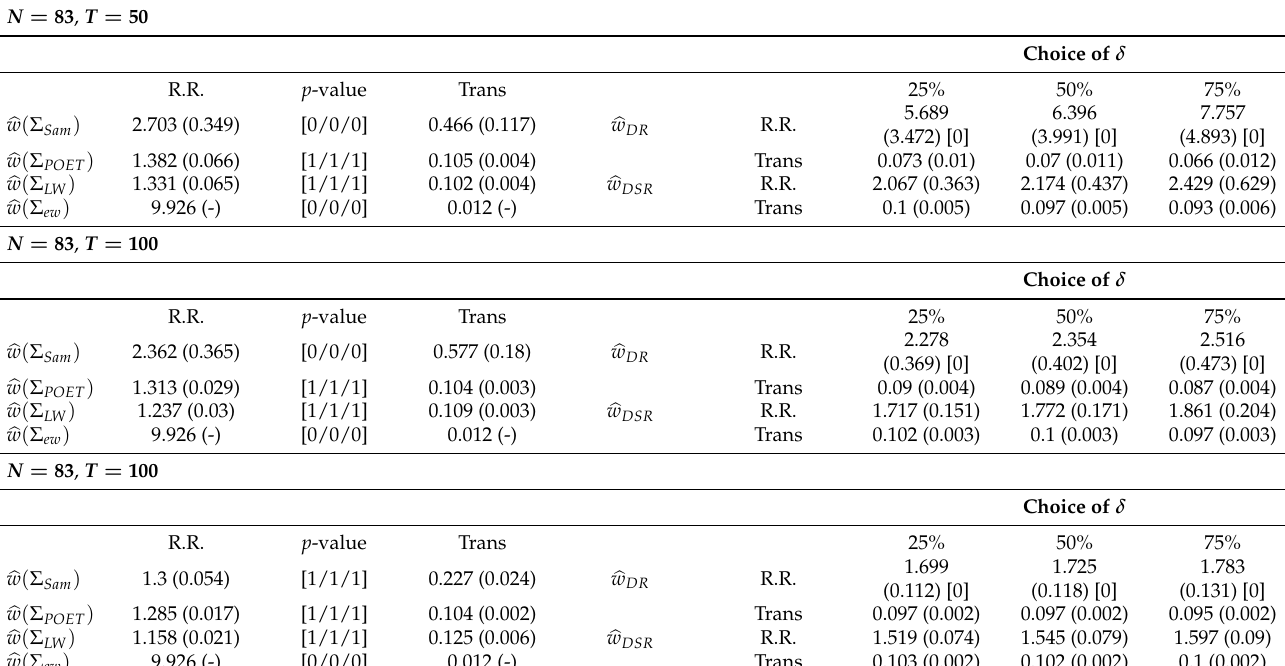
Table 3. Comparison of various GMVP